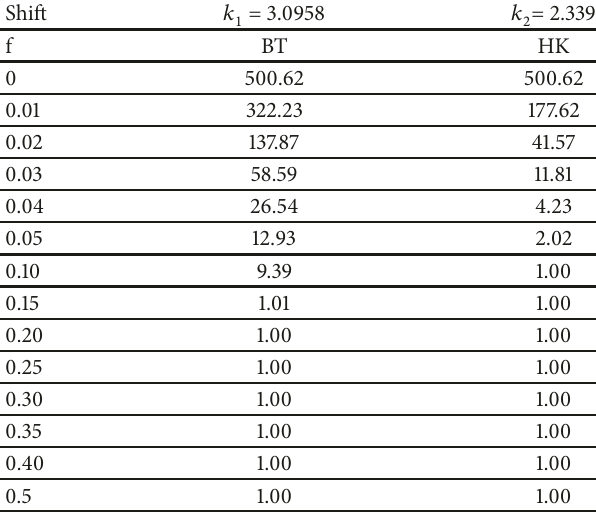
1.00 Table 17: Average run lengths for proposed repetitive EWMA-RSS control charts using exponential ratio-type estimators, for 𝜌 = 0.50 when 𝑟 𝑜 is 370 at 𝜆 =